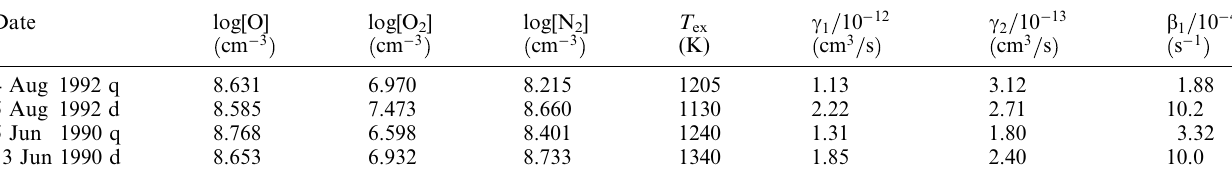
Table 4. Calculated aeronomic parameters for quiet (q) and disturbed (d) days at 300km altitude